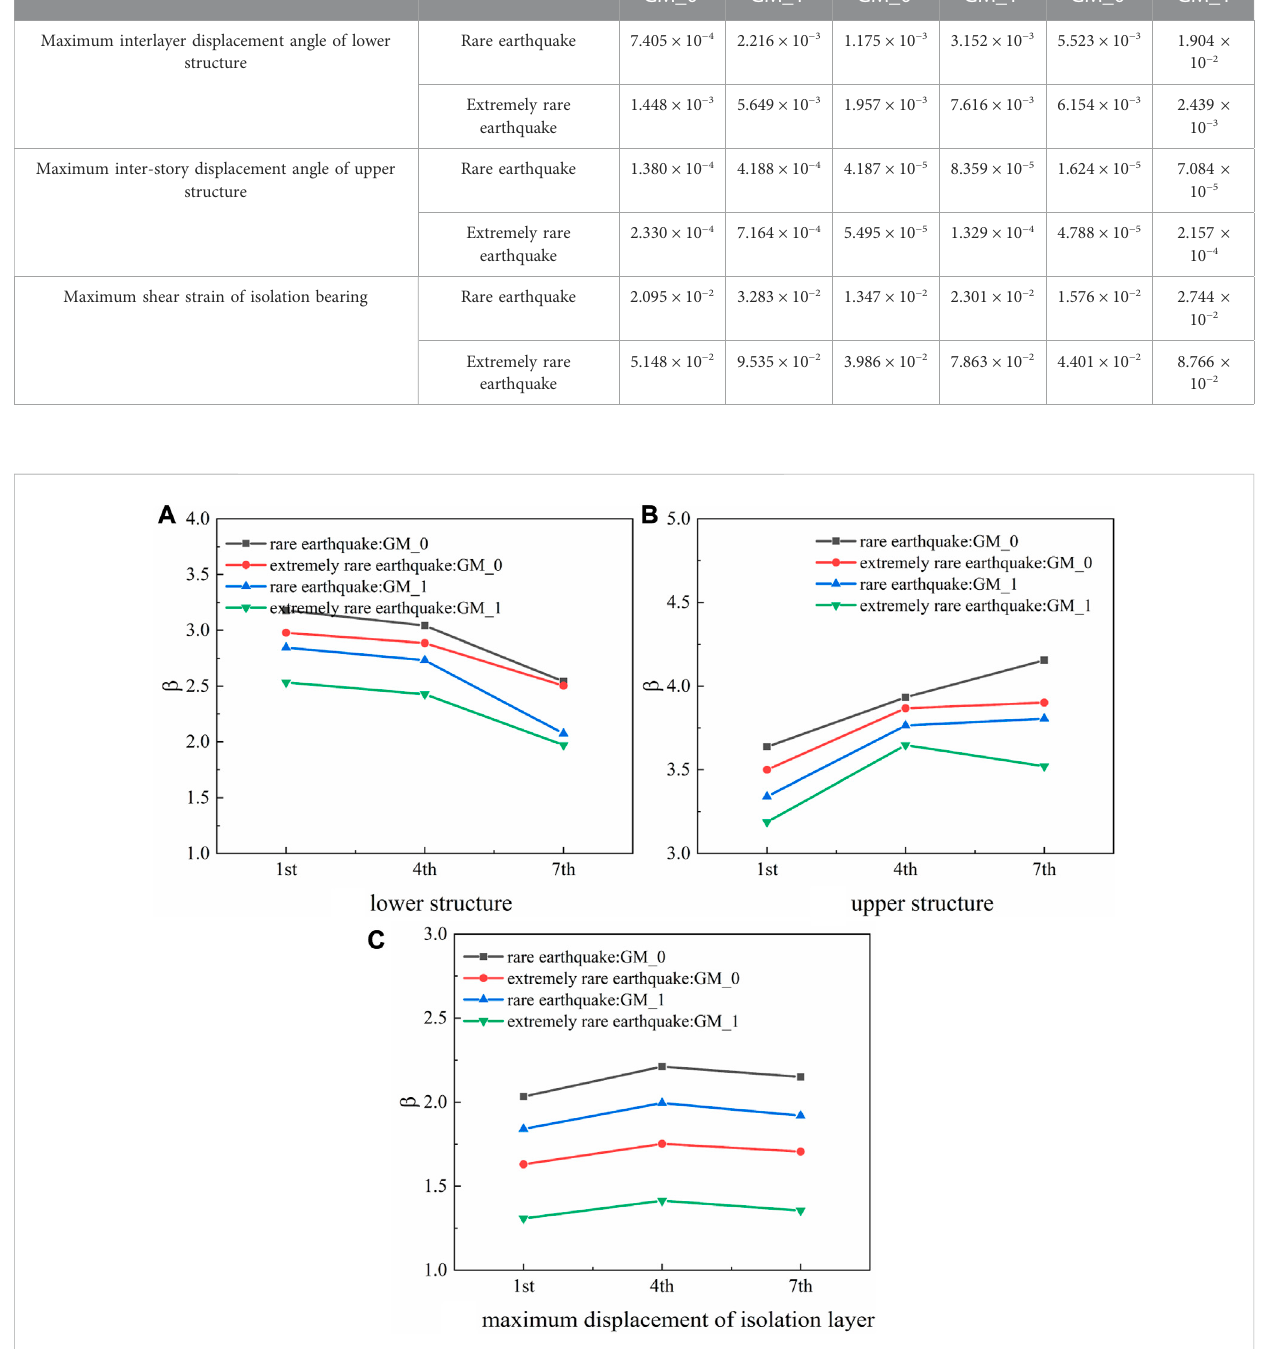
The overall reliability probability of different isolation layer locations was calculated using Eq. 16 and listed in Figure 10. Under the rare earthquake level, the overall reliability probability under the mainshock was the highest at 0.985 when the isolation